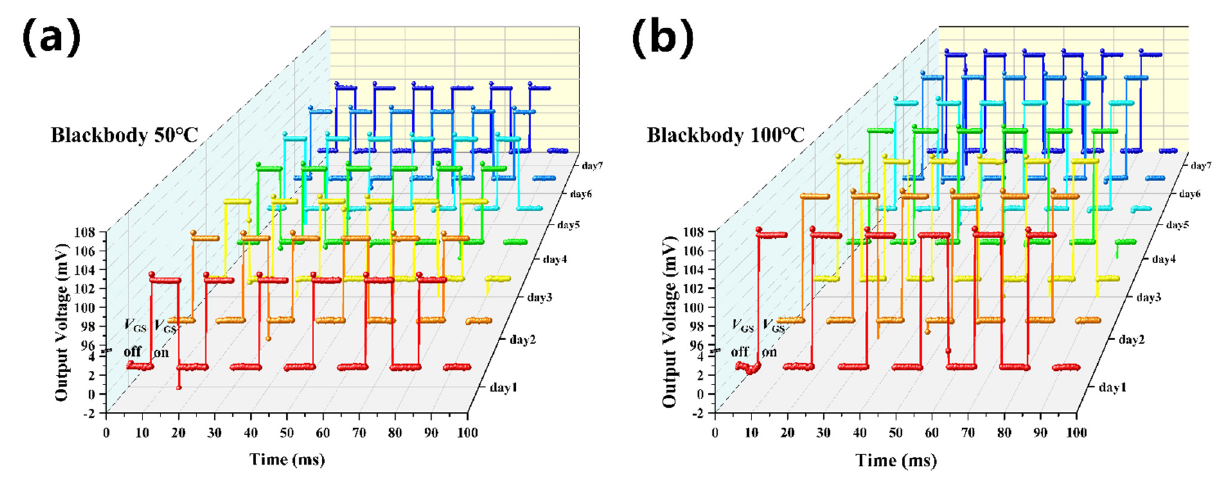
Figure 10. A one − week reliability test at blackbody temperatures of 50 °C ( a ) and 100 °C ( b ) re- spectively.